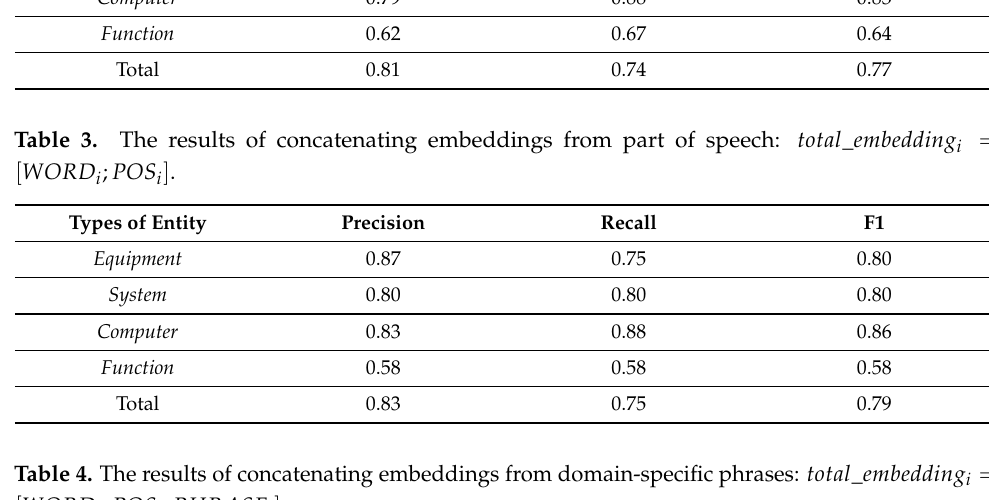
Table 4. The results of concatenating embeddings from domain-specific phrases: total _ embedding i =